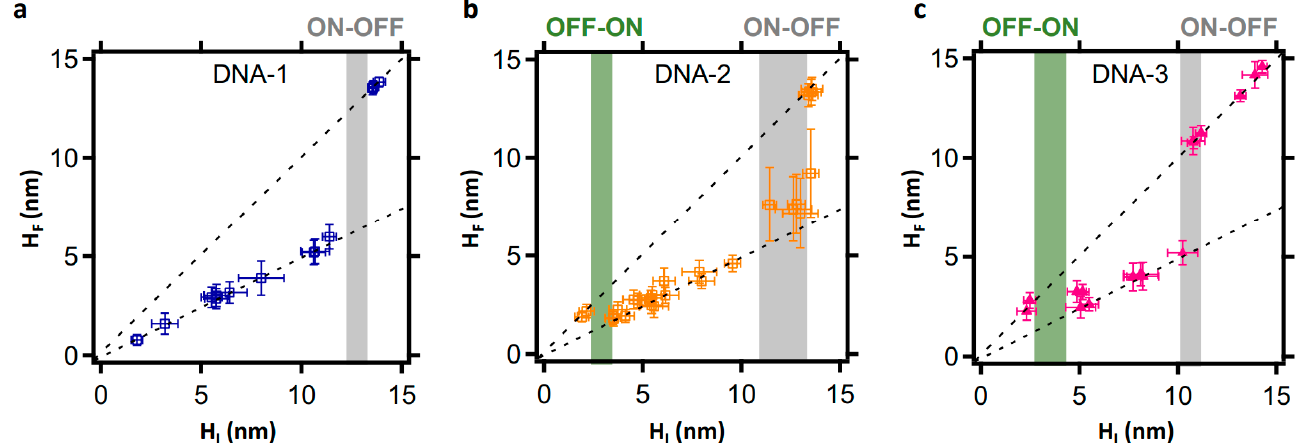
Figure 5. Correlation plots of the relative final height versus the relative initial height, showing the general sequence-density dependence of BamHI action. The plots also show ON-OFF (grey bars) and OFF-ON (green bars) thresholds, indicating the density range where the action of BamHI is ON and the density ranges where it is OFF. The plots in ( a – c ) highlight the behaviour of BamHI in in LCDMs, made up of DNA-1, DNA-2, and DNA-3, respectively.